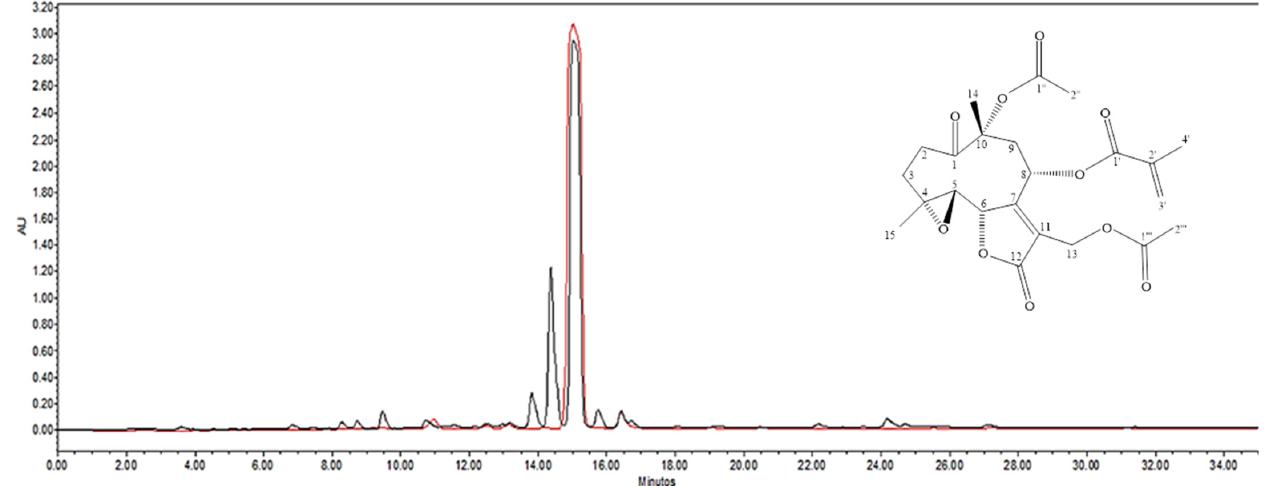
Figure 2. HPLC-DAD chromatograms of Vp-LRE (black line) and isolated glaucolide A (red line), and the chemical structure of glaucolide A.